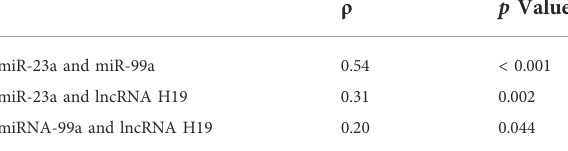
an independent predictor of functional outcome at 3 months The bene fi t of the addition of the noncoding RNA score for predicting the excellent outcome after rtPA treatment was assessed by the improvement of discrimination and reclassi fi cation of the predictive models, adding the noncoding RNA score to the clinical variables improved the integrated